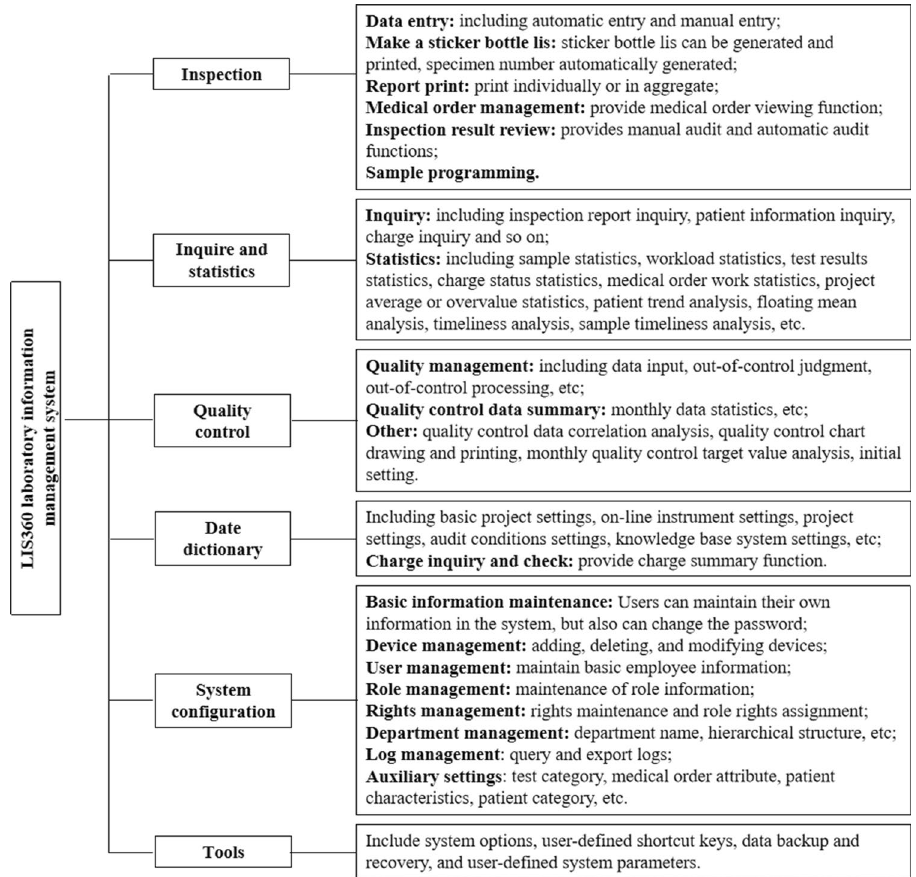
Fig. 3 System function module